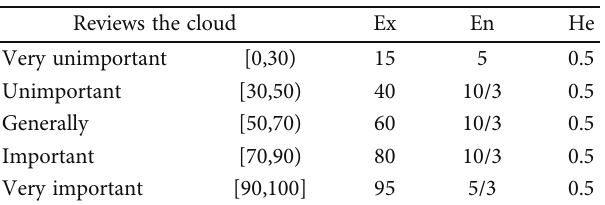
Figure 3: Index system of factors a ff ecting the freight rate of railway bulk goods. Table 2: Comment on cloud quantitative characteristics of railway bulk freight tari ff